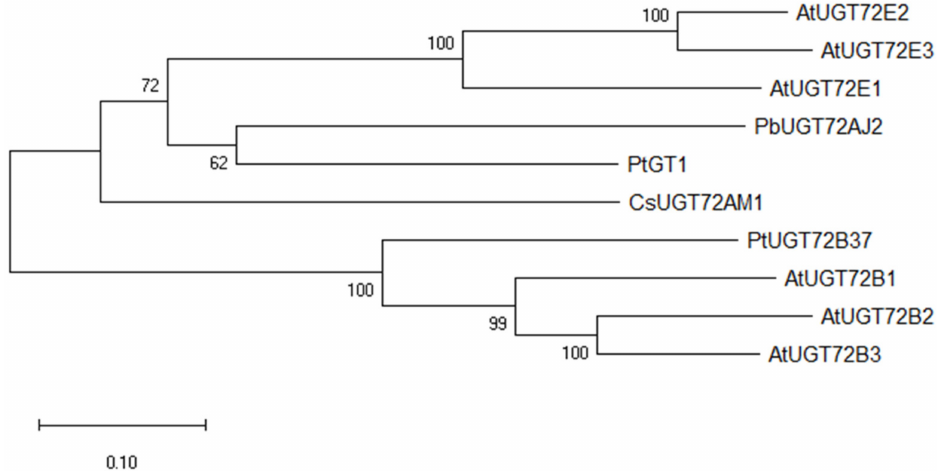
Figure 1. Phylogenetic tree of PbUGT72AJ2 and UGT homologues from other plants. The phylogenetic tree was constructed using MEGA 7.0 [38] with the neighbor-joining